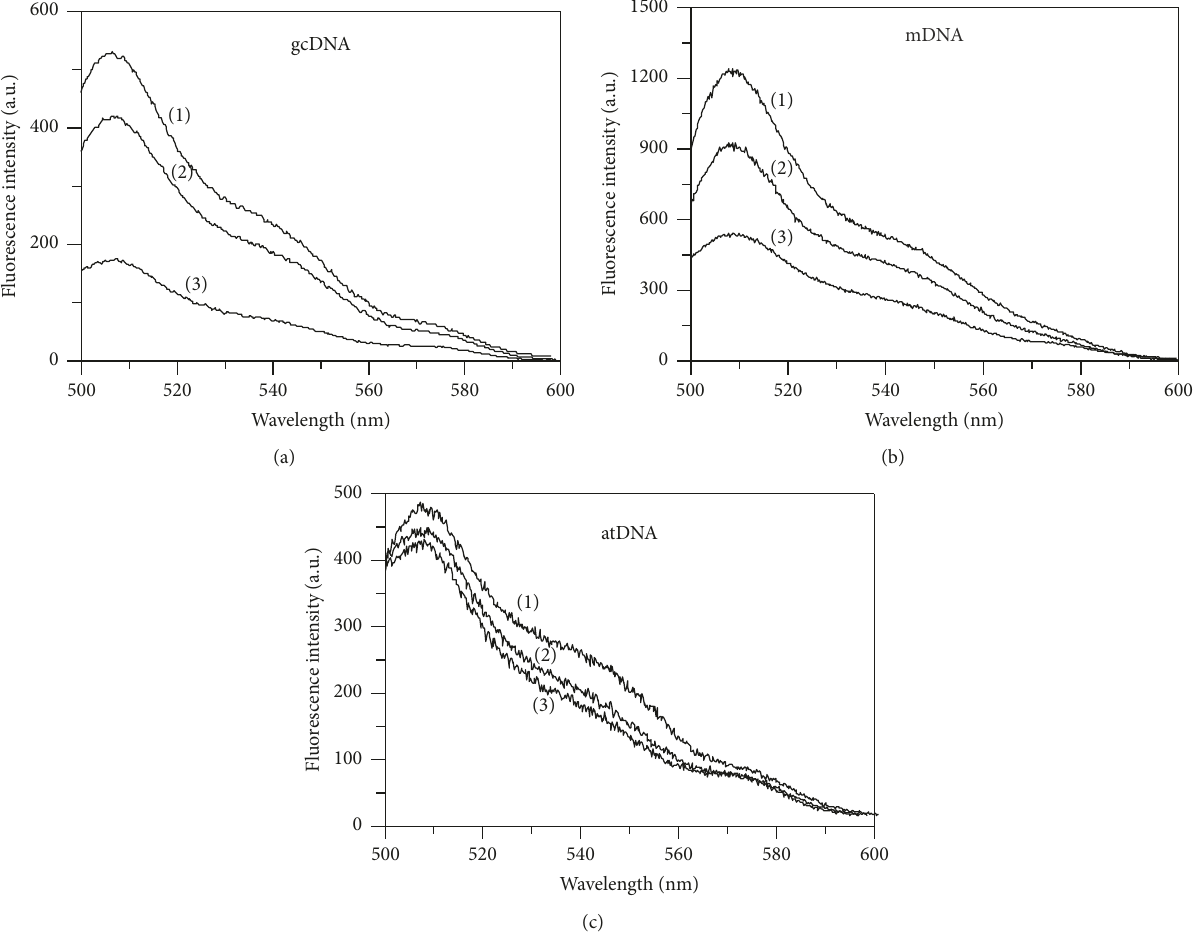
Figure 3: Concentration-dependent effect of 𝛼 -PrP on the emission spectra of YOYO intercalated in gcDNA, mDNA, and atDNA. Traces (1), (2), and (3) in each figures ((a), (b), and (c)) represent the dye fluorescence intercalated in these DNAs, respectively, in 20 mM Hepes buffer, pH 7.4 containing 100mM NaCl. Traces (2) and (3) are the dye fluorescence spectra after the addition of 0.6 and 1.2 𝜇 M 𝛼 -PrP, respectively. DNA and dye concentrations in the experiments were 400 nM phosphate and 8nM dye. Excitation 485 nm. Temperature 20 ∘